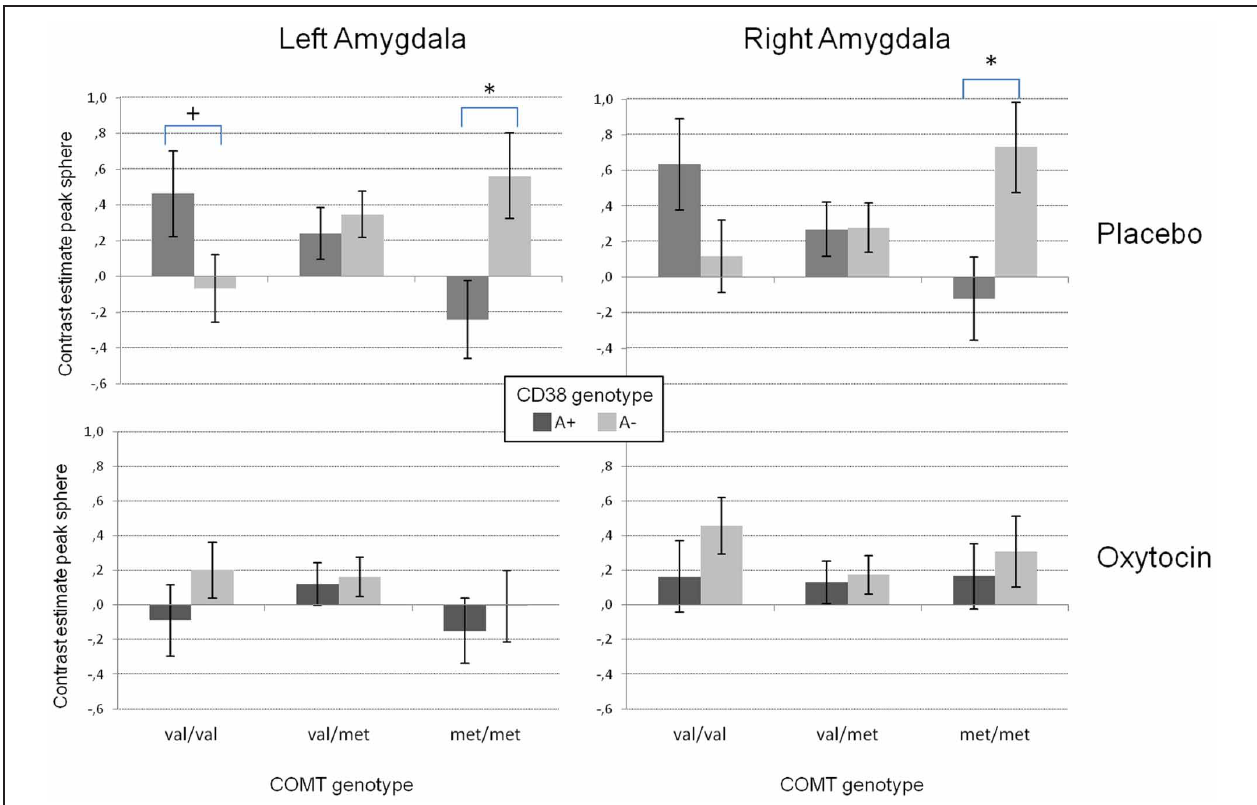
substance. While there is a clear interaction between the investigated genetic variants in the placebo condition ( upper panels ), this interaction